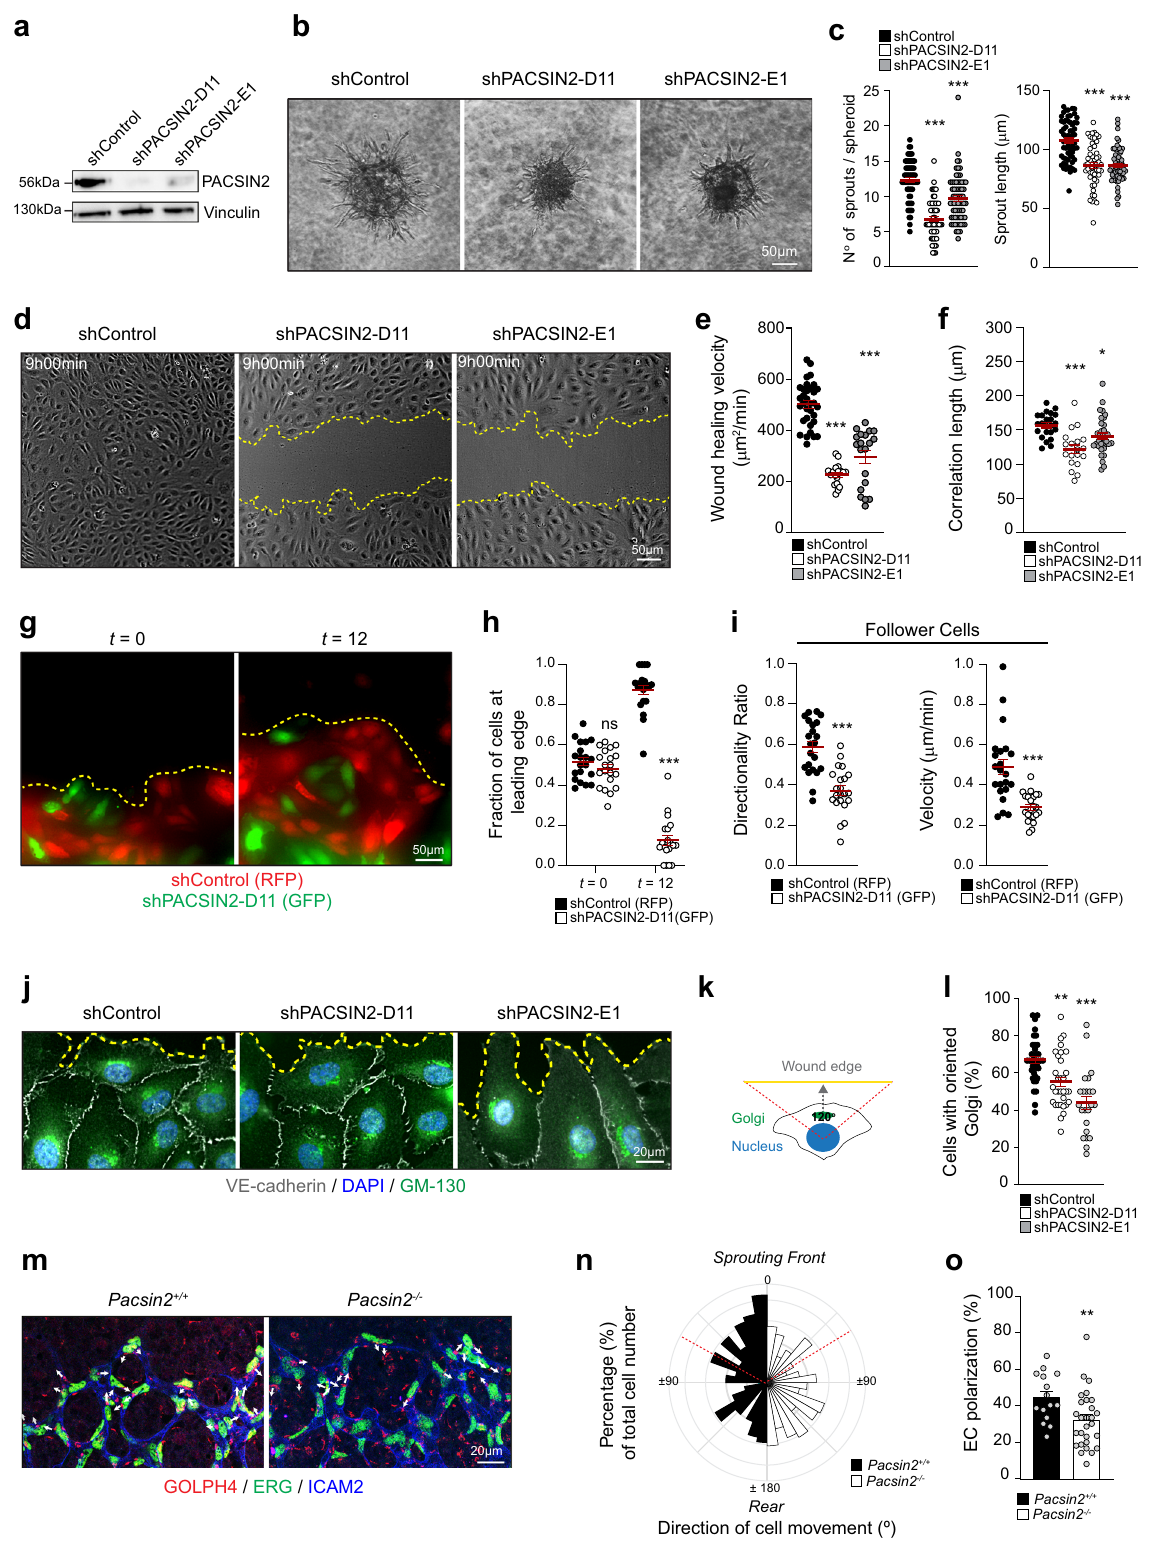
aligned in the direction of collective migration (Supplementary Fig. 4). To study whether PACSIN2 and EHD4 bind to each other, we next conducted GFP-tag-based immunoprecipitations (IPs) on lysates of HUVECs expressing either PACSIN2-GFP or EHD4-GFP. Endogenous EHD4 was ef fi ciently pulled down in PACSIN2-GFP IPs (Fig. 4d, e), and vice versa endogenous